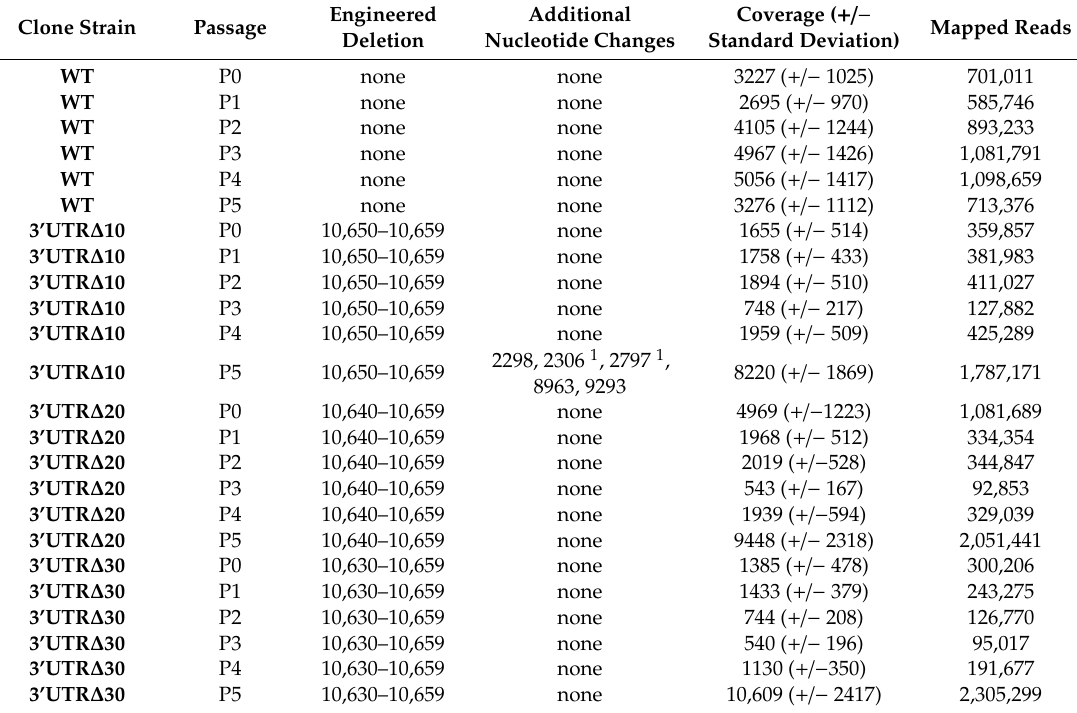
Table 1. Description and analysis of infectious clone-derived viruses used in the study. Clone Strain